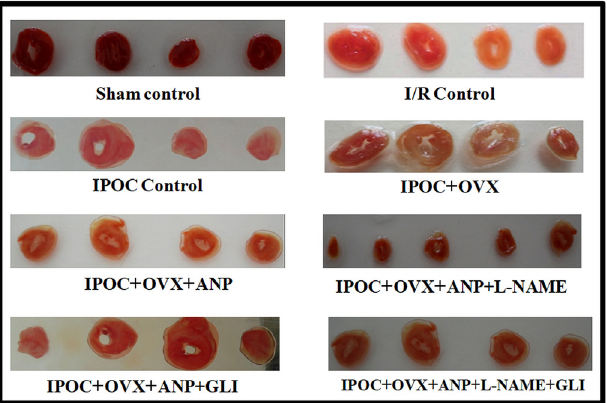
FIGURE 2 - Images of the TTC-stained transverse sections of heart